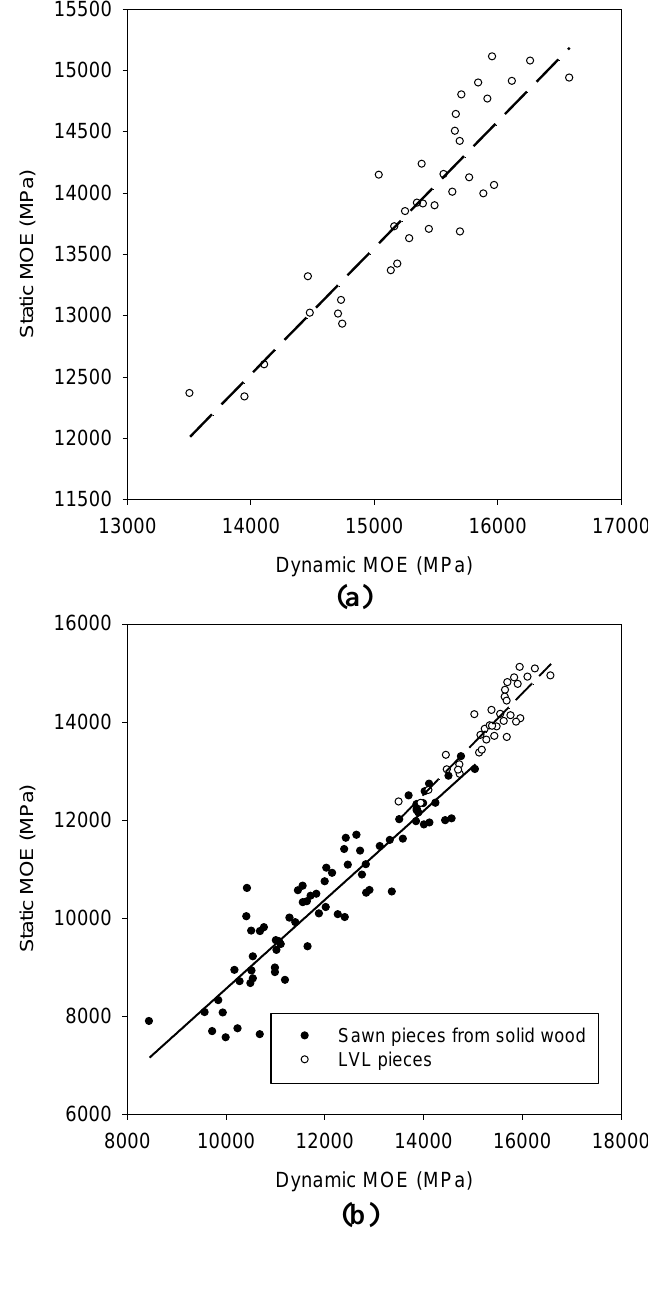
Figure 4. (a) Relationship between static MOE measured on LVL pieces and dynamic MOE. R 2 = 0.83. (b) A comparison of the relationships between static and dynamic MOE for traditional sawn lumber (filled circles) and LVL boards (empty